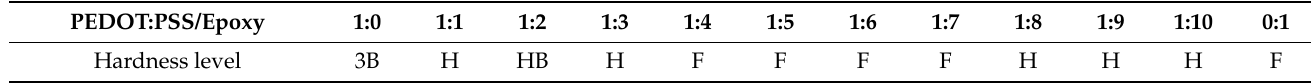
Table 1. The pencil hardness properties of PEDOT:PSS/epoxy coatings under different P:E ratios.